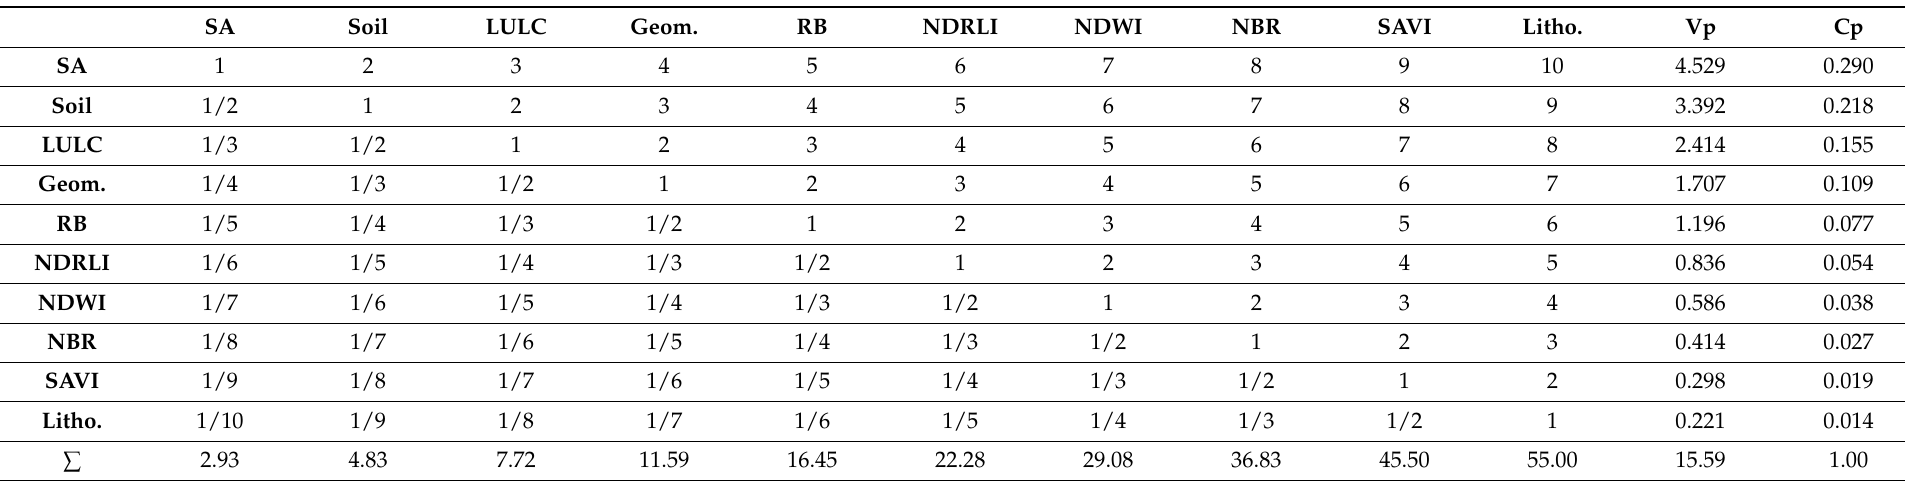
Table 2. Pairwise comparison